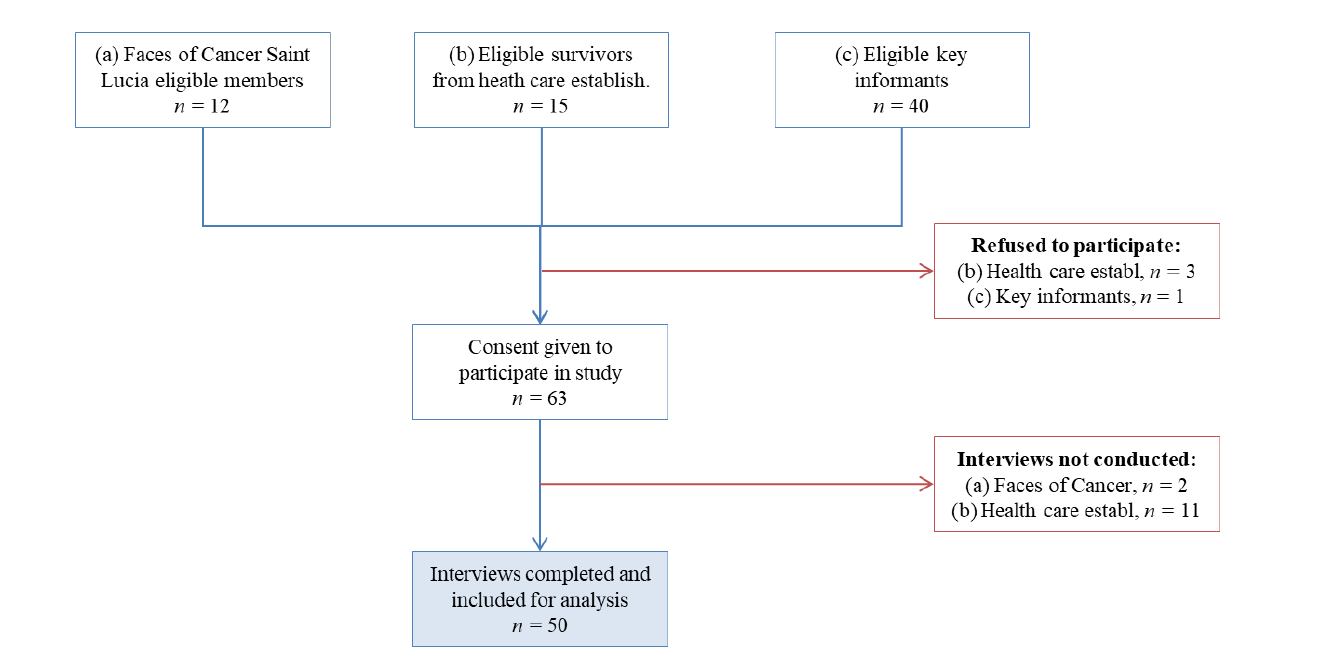
Figure 1. Flow chart of subject inclusion for pilot survey on cancer pathways. A little over half of the cancer survivors were women with breast cancer ( n = 26) (Table 1). Seventy percent resided in urban areas (Castries and Gros-Islet), with others residing in smaller towns (Soufriere, Micoud, and Vieux-fort). Table 1. Sociodemographic characteristics of cancer survivors by cancer site .